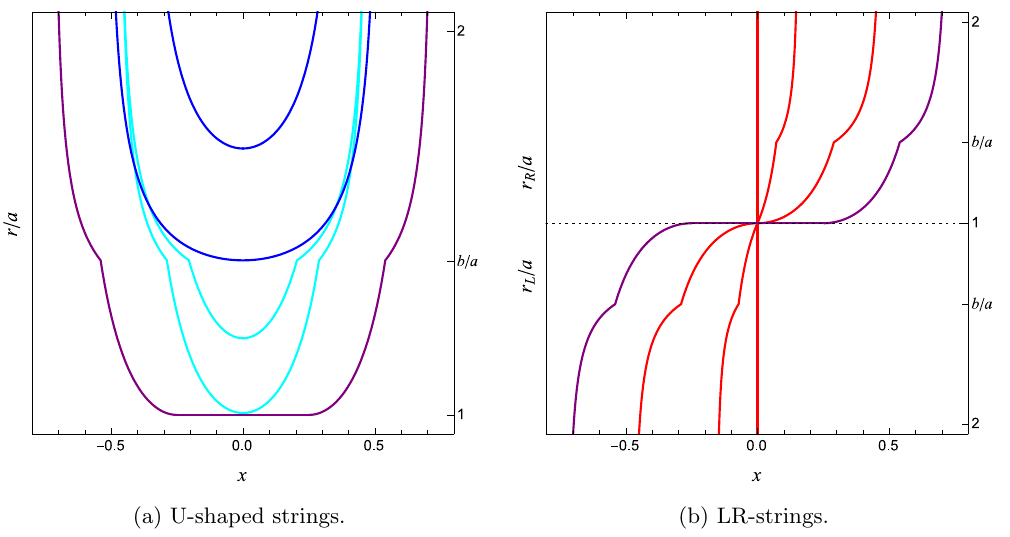
Figure 4 . String dioptrics in the thin-shell wormhole.